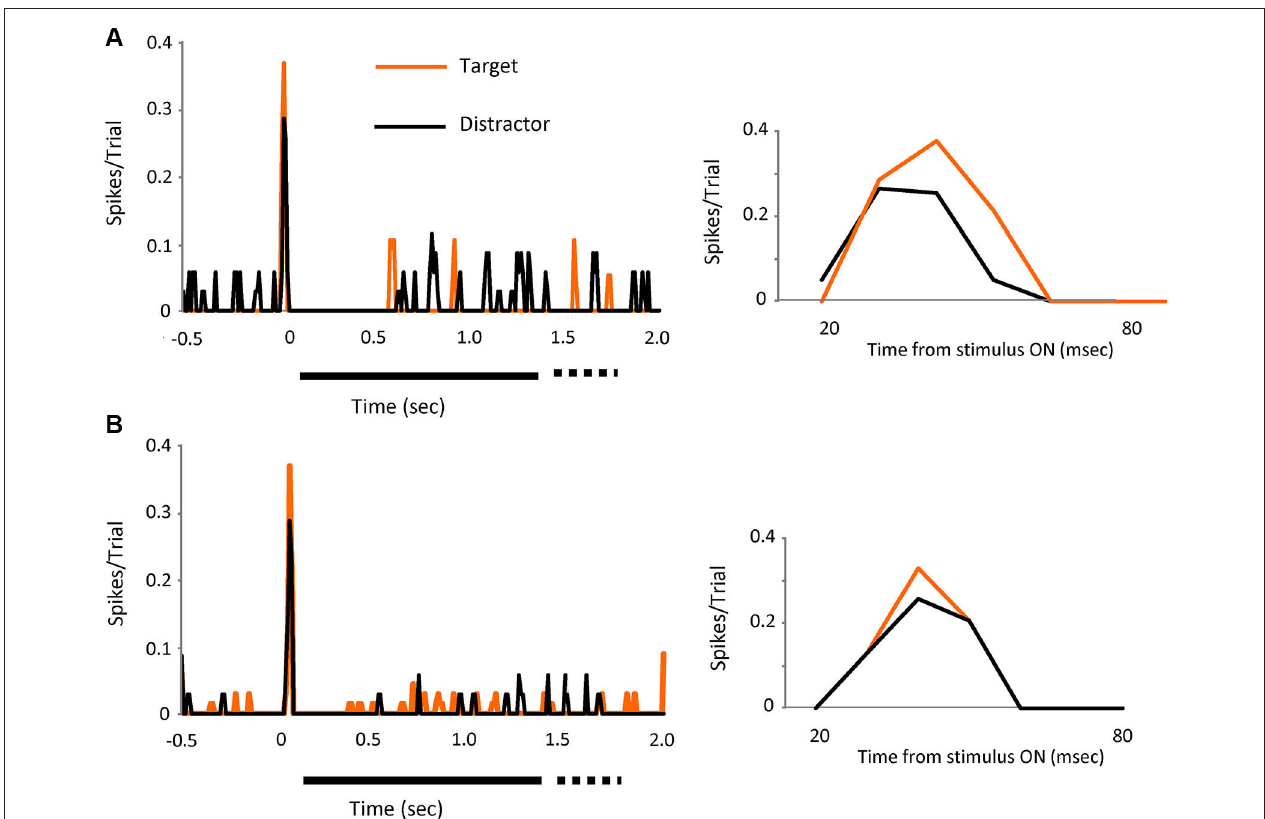
(black line). Left PSTH’s show increases in peak response for both cells when the target was on the receptive field. Bin size 10 ms. Right PSTH’s shows a detailed view of the initial part of the response (20 to 80